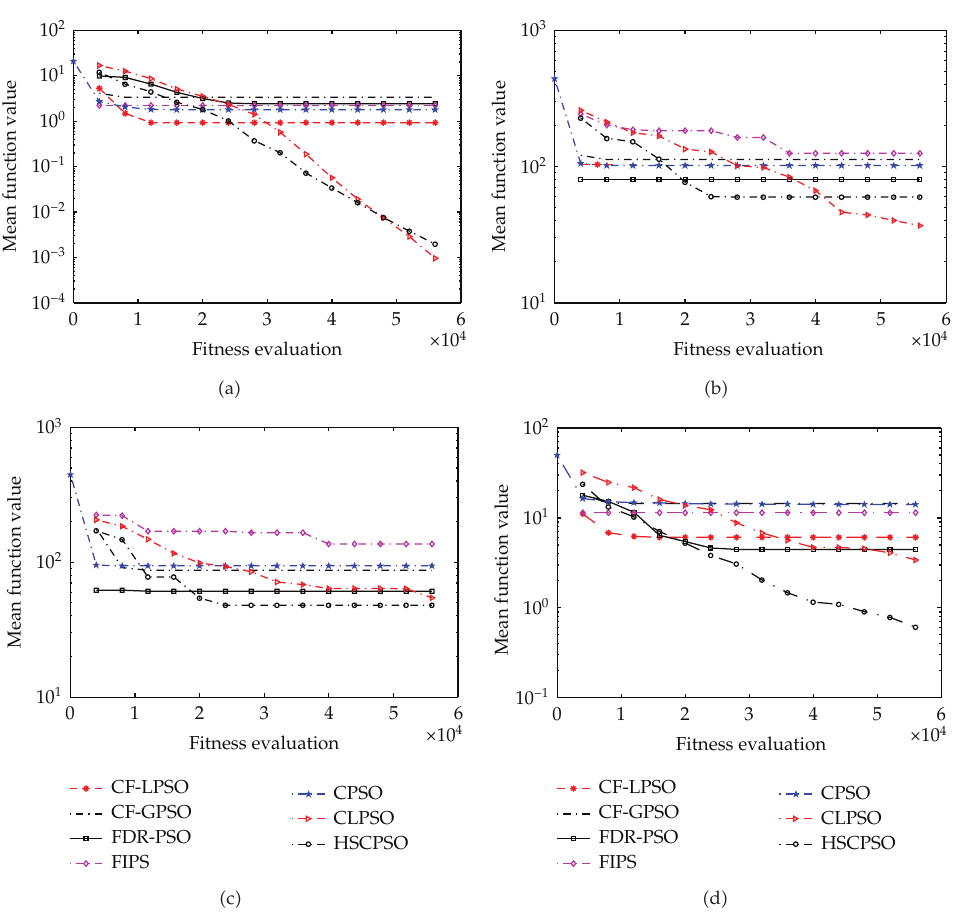
Figure 10: Convergence characteristics of the rotated test functions. (cid:2) a (cid:3) Ackley; (cid:2) b (cid:3) Rastrigin; (cid:2) c (cid:3) Rastrigin noncont; (cid:2) d (cid:3)